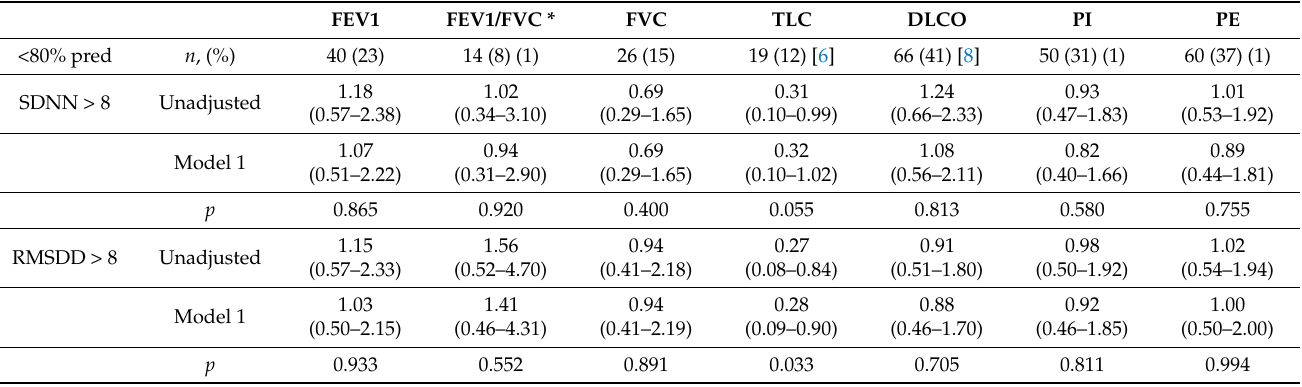
Table 2. Odds ratios with confidence intervals for abnormal pulmonary function between 3 and 5 months after hospitalization with COVID-19 using multivariate logistic regression.